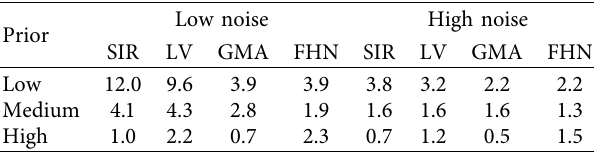
Table 2: MSE ratios for linear parameters (large